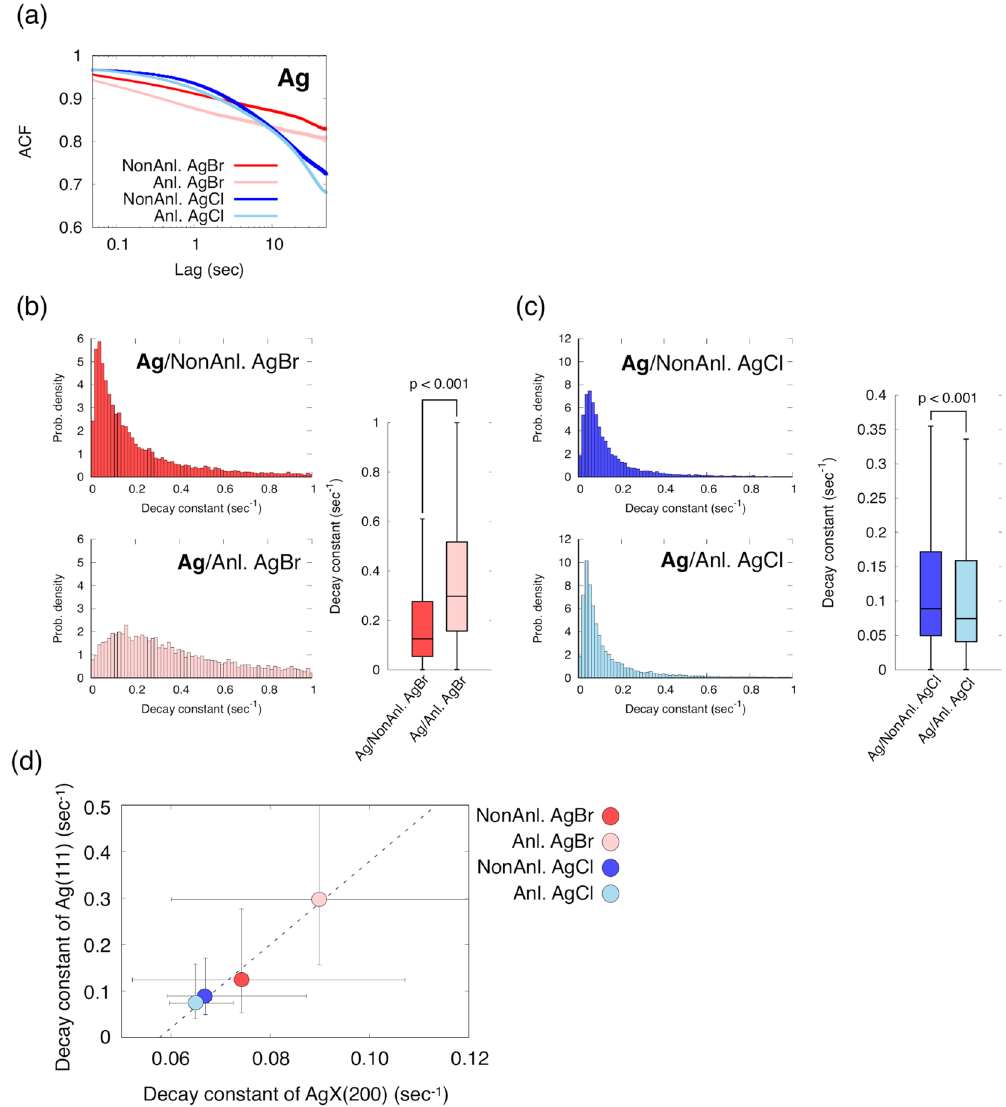
Figure 5. ACF analyses in metallic silver Ag(111). ( a ) Mean ACF curves for Ag for each AgX sample. ( b , c ) Histogram and boxplot of the decay constant of Ag. The distribution of the ACF decay constants was compared between non-annealed and annealed samples of Ag/AgBr and Ag/AgCl. The boxes show the median and first and third quartiles. The nonparametric Brunner–Munzel test was performed to compare two samples. ( d ) A correlation of the ACF decay constants between AgX(200) and Ag(111). The dashed line was determined by linear